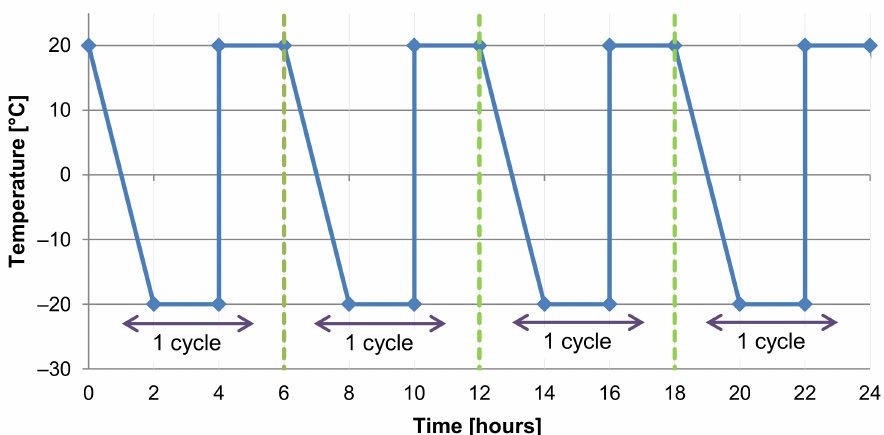
Figure 7. Temperature course of frost/defrost cycles; 4 cycles—24 h; phase 0–4 h of one cycle takes place without the presence of water, and during the final phase of the cycle 4–6 h, the testing chamber is filled with water, where the test specimens are submerged at (20 ± 2) ◦